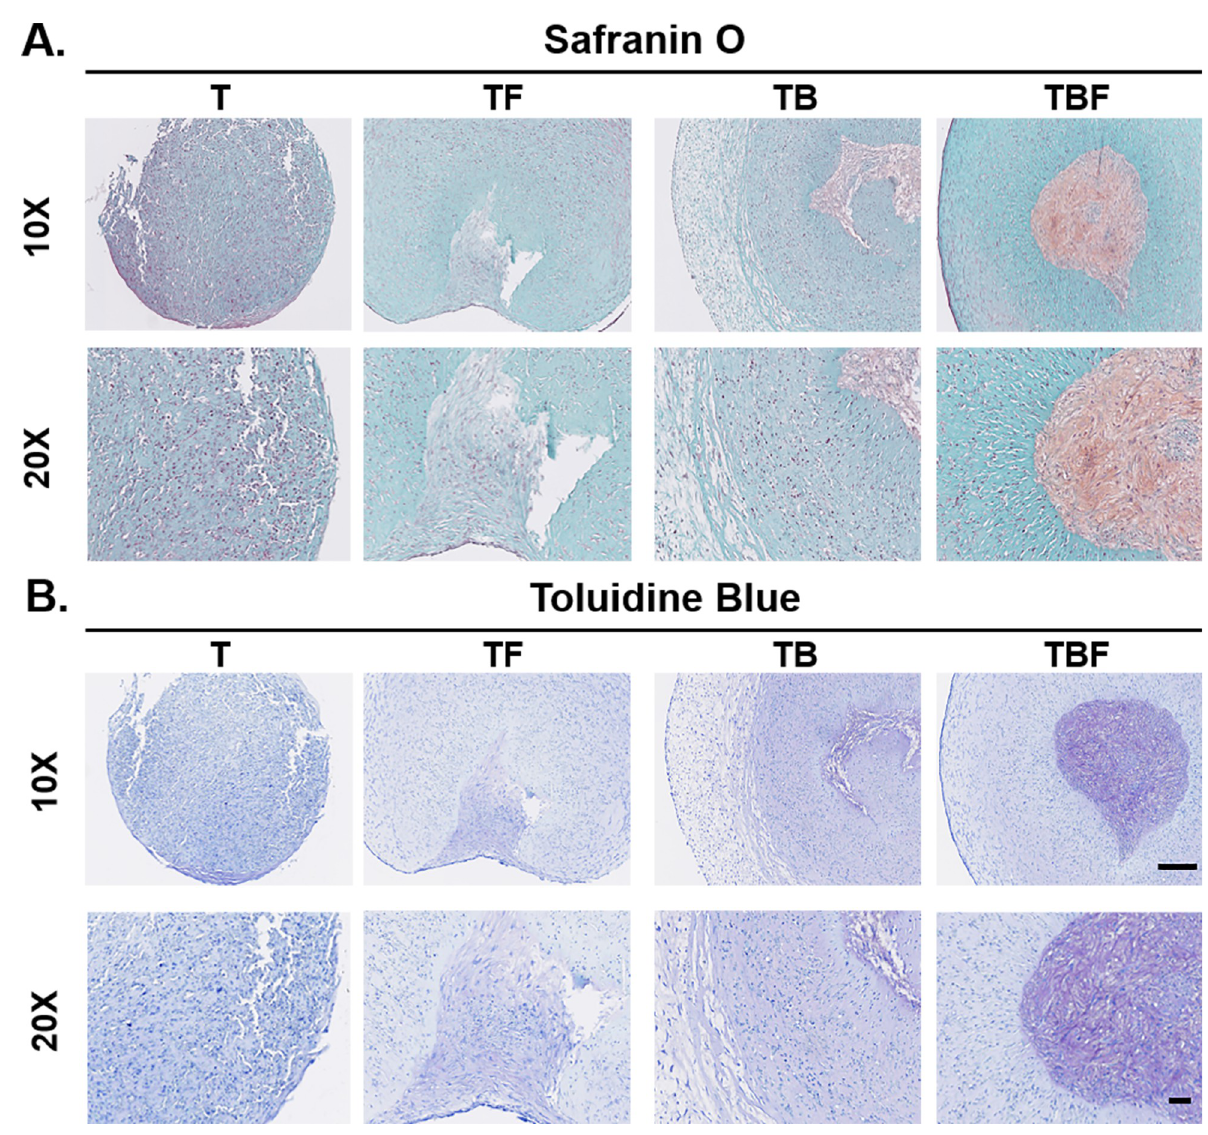
Fig 8. Safranin O and toluidine blue histology. Constructs were fixed and processed after 21 days of culture for histologic assessment with safranin O (A) or toluidine blue (B). Constructs treated with TGF- β 3 (T) did not exhibit any evidence of chondrogenic differentiation. Constructs treated with TGF- β 3 and bFGF (TF) exhibited small zones of faint proteoglycan deposition. Constructs treated with TGF- β 3 and BMP-2 (TB) demonstrated focal regions of more convincing proteoglycan deposition, but contained a large rim of myxomatous tissue that lacked any proteoglycan staining. Constructs treated with TFG- β 3, BMP-2, and bFGF (TBF) contained large zones of proteoglycan-rich ECM. Cells within these regions were spherical and produced lacunae-like structures and were morphologically similar to chondrocytes. Bars = 250 μ m (10X) and 100 μ m